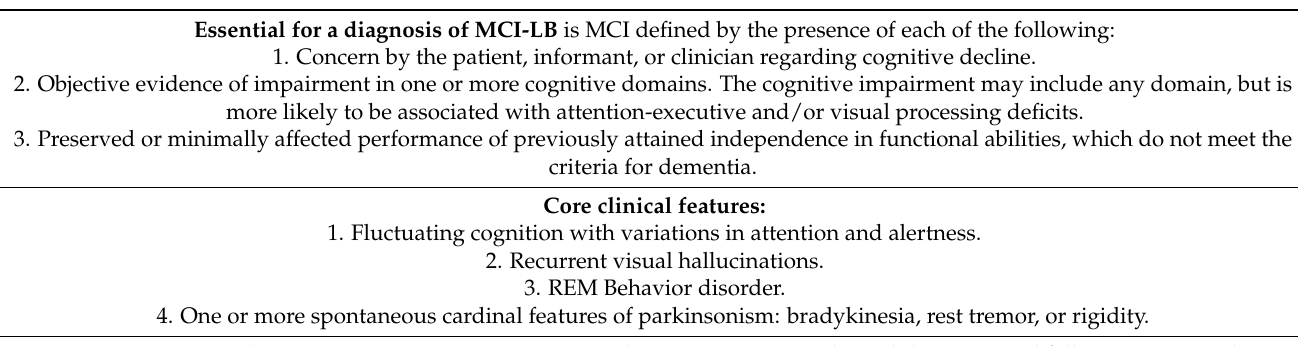
Table 2. Research criteria for the clinical diagnosis of probable or possible mild cognitive impairment due to Lewy body dementia